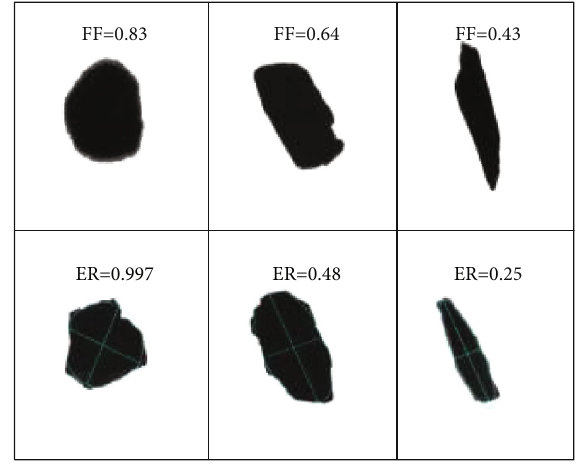
Figure 9: Coal sample particles of di ff erent form factors (FF) and ellipse ratio (ER).